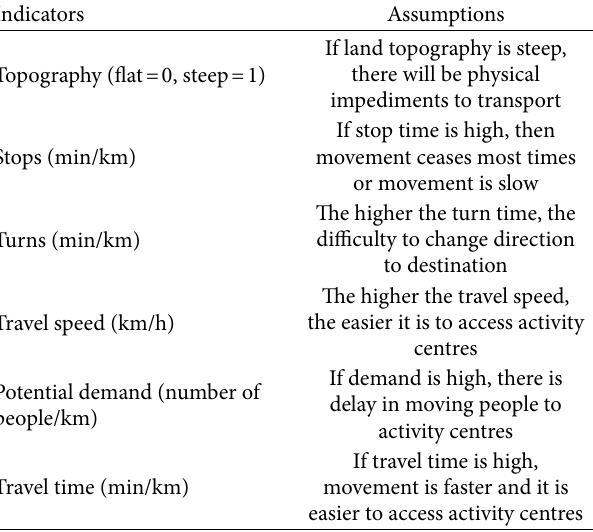
Table 1: Barriers as indicators modelling